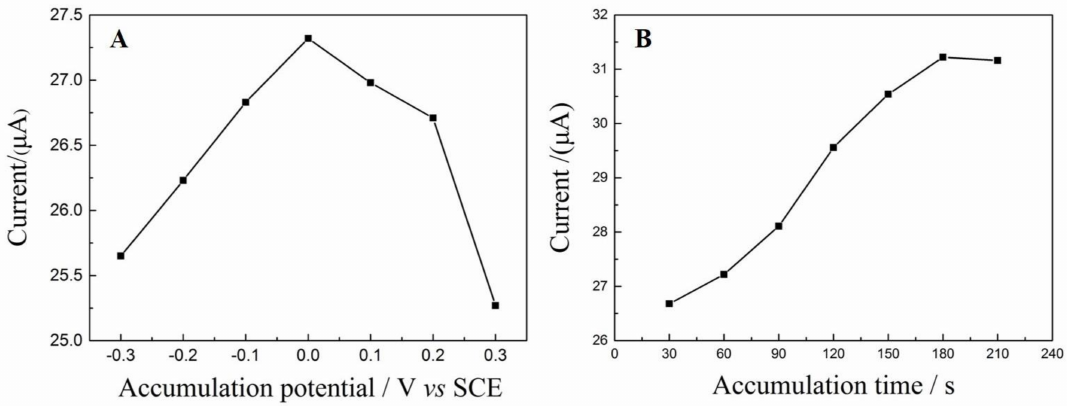
Figure 9. Effect of accumulation potential and time. ( A ) the oxidation peak currents ( i pa ) of DA after 210 s accumulation at various accumulation potential; ( B ) the oxidation peak currents ( i pa ) of DA after accumulation at 1.5 V for 30–210 s.